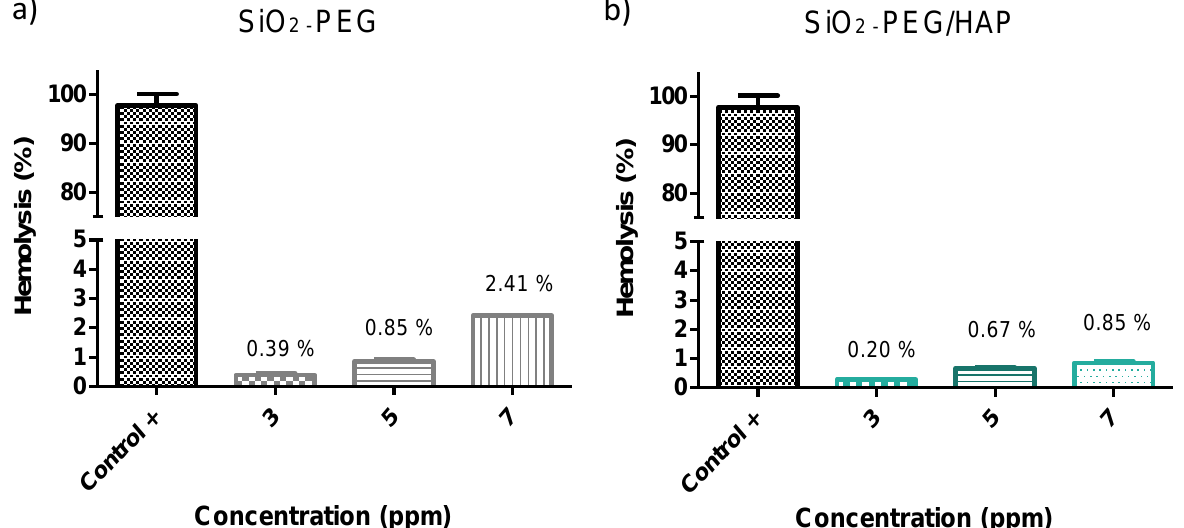
Figure 9. Percentage of hemolysis of ( a ) SiO 2 -PEG and ( b ) SiO 2 -PEG/HAp samples.